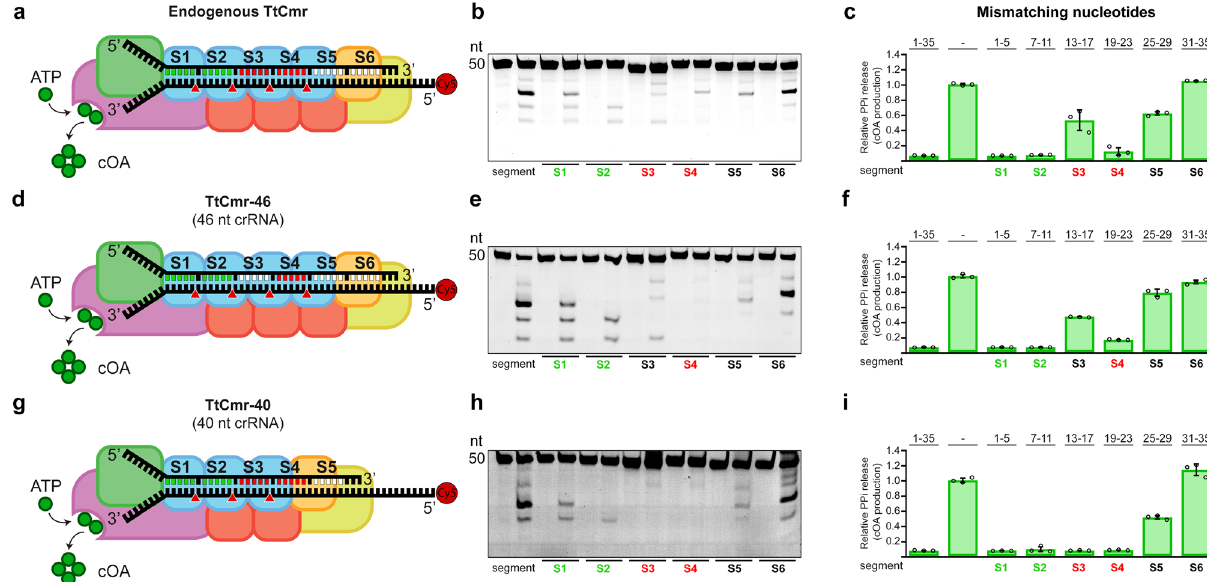
Fig. 3 A fl exible seed region at the 3 ′ end of the crRNA. a Schematic illustration of the endogenous TtCmr complex. b Different target RNAs with segments mismatches were used in an activity assay and analyzed on denaturing PAGE. c Impact of target RNAs with mismatches in the indicated segments on the production of cOA. d Schematic overview of the 46 nt crRNA complex (TtCmr-46). e Similar to panel b , using the 46 nt crRNA complex (TtCmr-46). f Similar to panel c , using 46 nt crRNA complex (TtCmr-46). g Schematic overview of the 40 nt crRNA complex (TtCmr-40). h Similar to panel b , using the 40 nt crRNA complex (TtCmr-40). i Similar to panel c , using the 40 nt crRNA complex (TtCmr-40). Target RNA contain a 5 ’ end Cy5 label (red circle); mismatched segments are indicated with S1 – S6. Red triangles indicate the cleavage sites within TtCmr. CAR segments are indicated in green, seed segments are indicated in red. The results of the cleavage assays and cOA production assays displayed in this fi gure are representative results of three independent experiments (Supplementary Fig. S6). Error bars represent the standard deviation of the mean. Source data are provided as a Source data fi